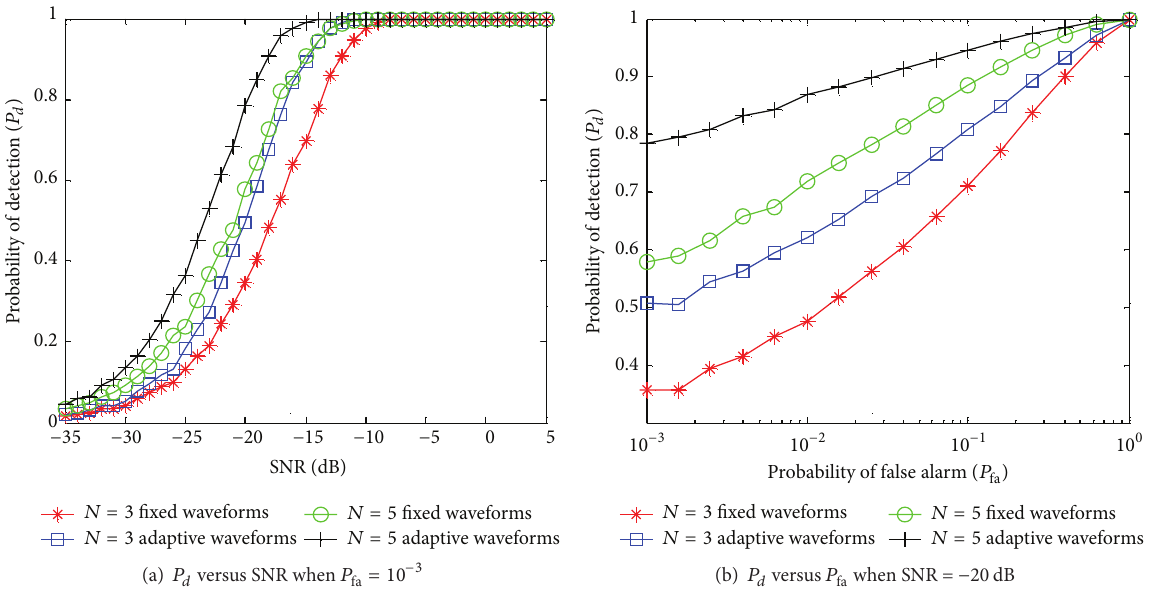
Figure 9: Comparison of detection performance with fixed waveform and adaptive